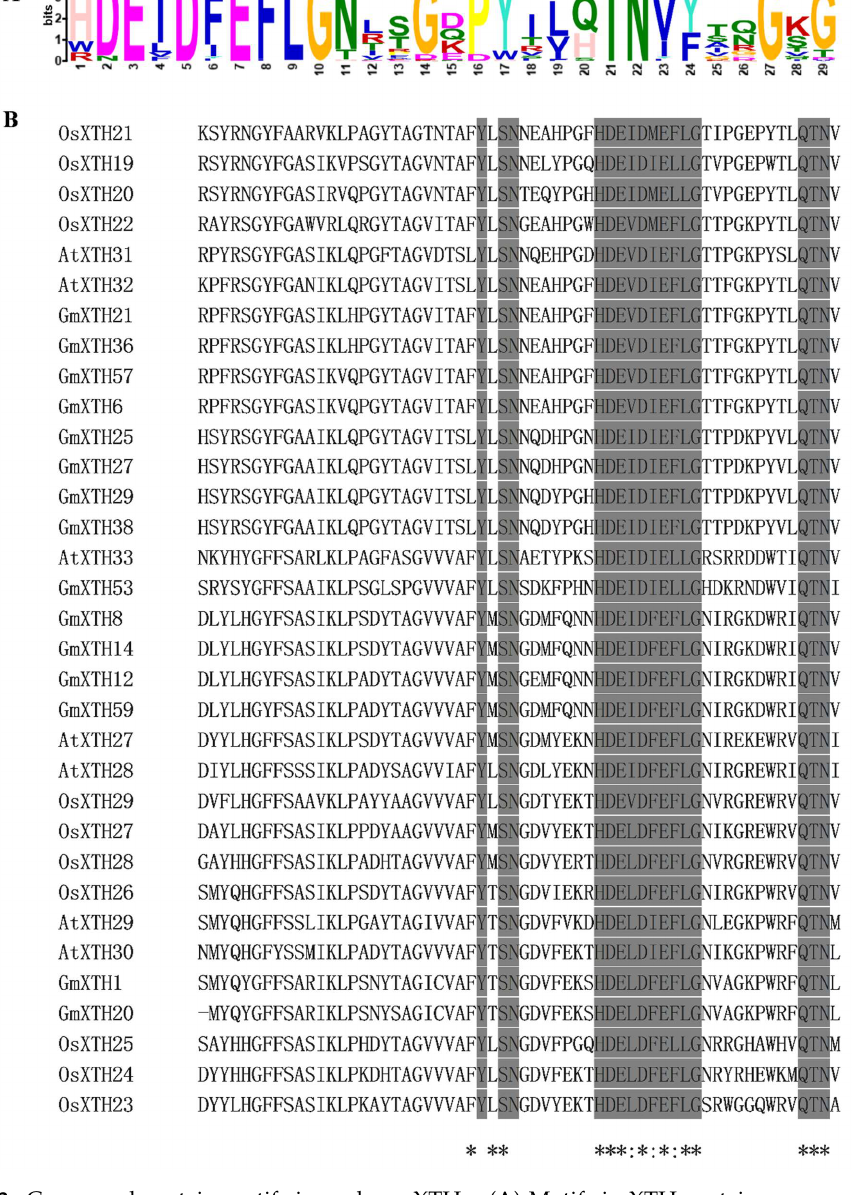
Figure 3. Conserved protein motifs in soybean XTHs. ( A ) Motifs in XTH protein sequences of 61 GmXTH identified with the MEME tool. ( B ) Alignment of the putative-site amino acid residues in group III XTH proteins from Arabidopsis , rice, and soybean constructed with the CLUSTALW2 program. Amino acid residues that are identical within this motif are indicated by gray shading. “*” means that the residues or nucleotides in that column are identical in all sequences in the alignment. “:” means that conserved substitutions have been observed.